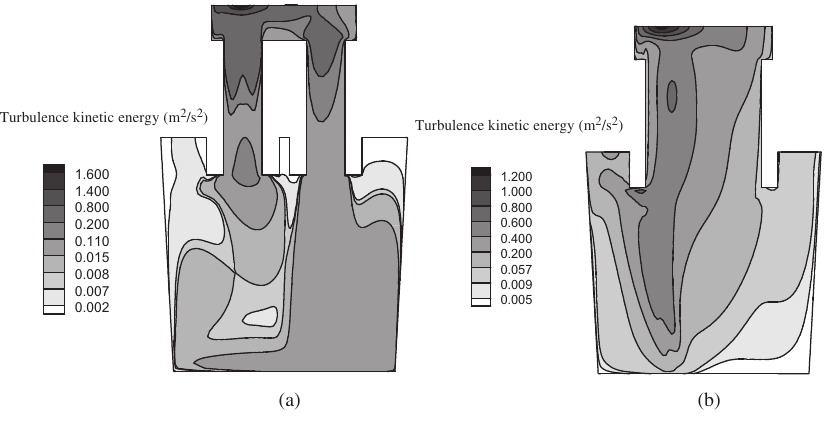
Figure 3: Distribution of turbulence kinetic energy at the main plane. (a) RH (b) SSF.